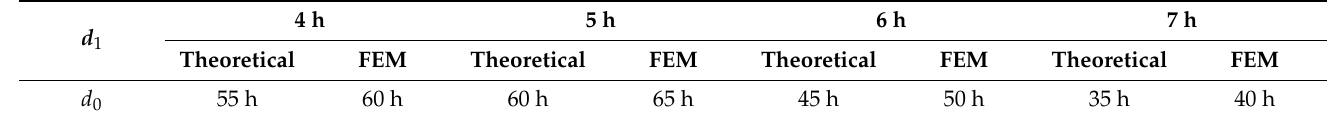
d d between the two resonator units with different electrode gap of between the two resonator units with different electrode gap of